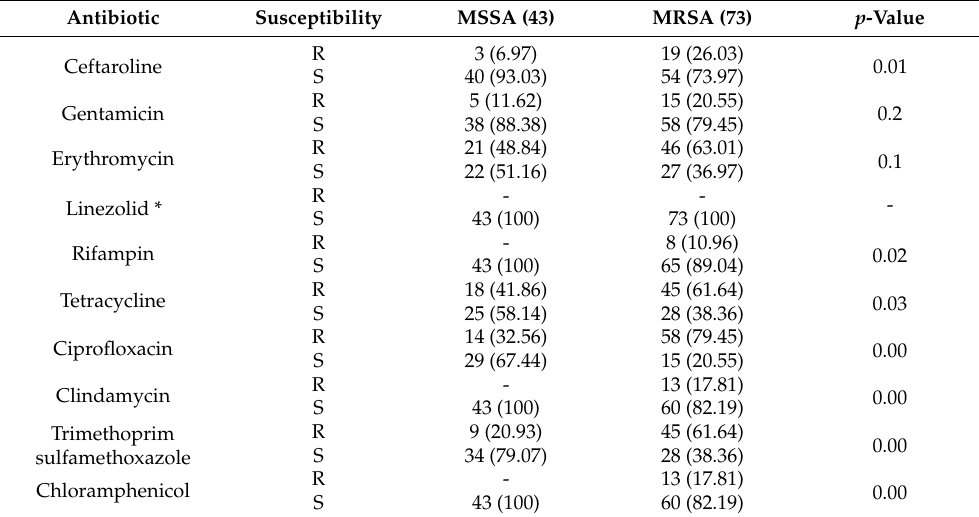
Figure 2. Prevalence of MRSA and MSSA in pyoderma cases. Table 3. Comparative analysis of non-β–lactam antibiotics susceptibility patterns of MSSA with MRSA isolates.